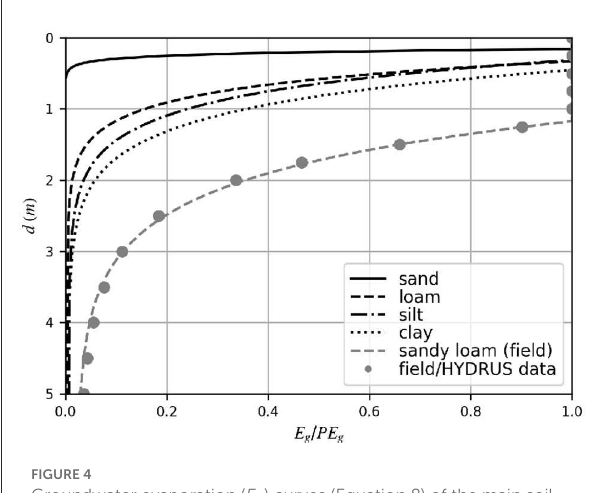
FIGURE4 Groundwater evaporation ( E g ) curves (Equation 8) of the main soil texture classes (after Shah et al., 2007). The soil texture class labeled “sandy loam (field)” corresponds to the results of Balugani et al. (2016) obtained from the La Mata catchment. PE g , groundwater potential evaporation; d , water table depth. Refer to Table 1 to consult the corresponding parameters and to Section 2.4 for detailed explanations.